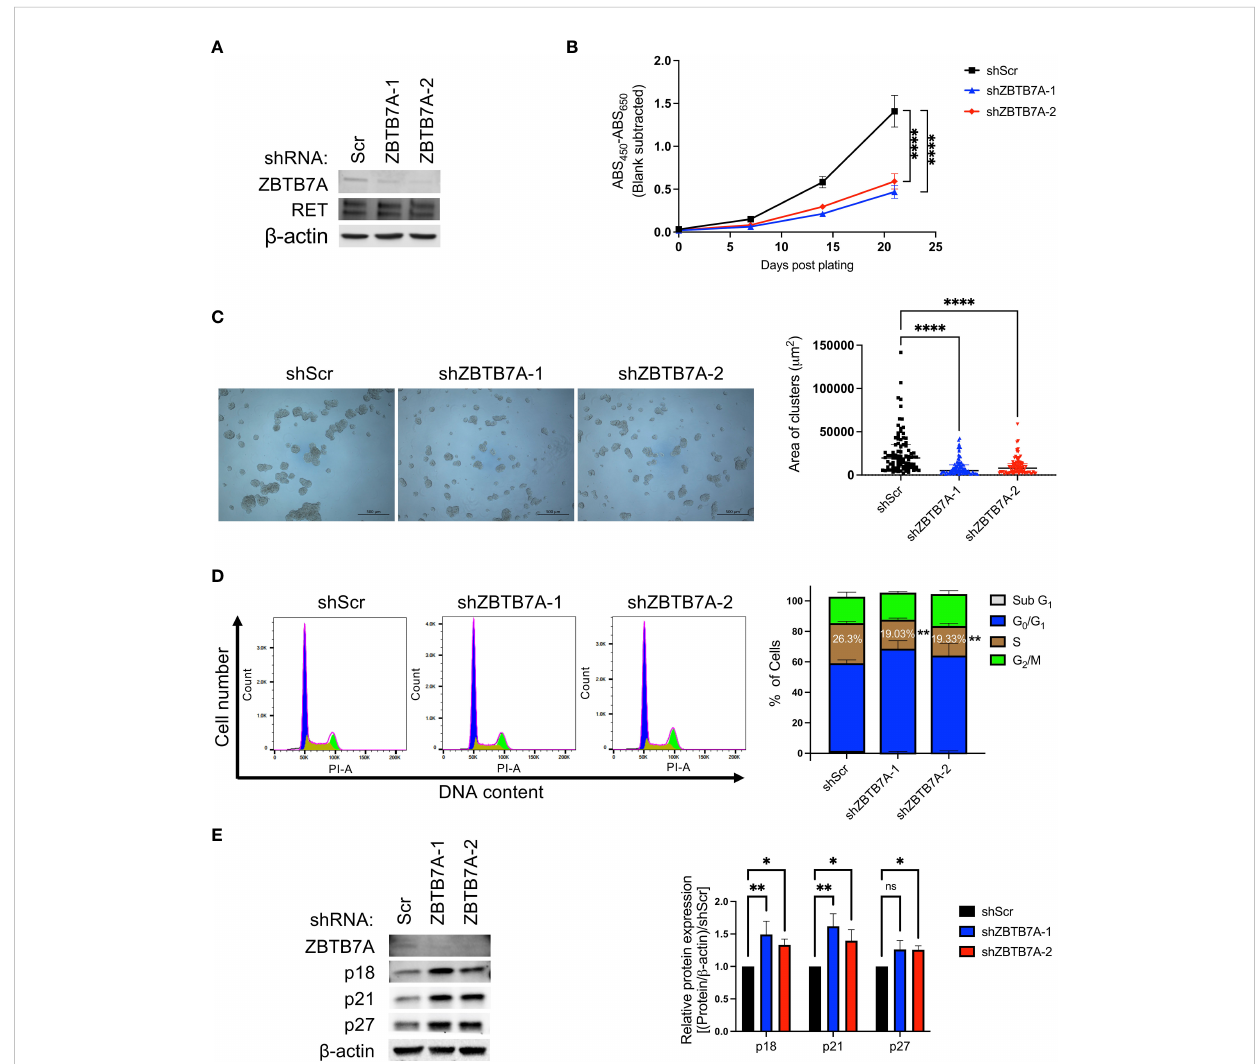
FIGURE 3 ZBTB7A knockdown reduced cell proliferation of NCI-H660 cells by blocking progression through the cell cycle. (A) ZBTB7A and RET protein expression in NCI-H660 cells stably transduced with scrambled (Scr) or two anti- ZBTB7A shRNAs. b -actin was used as a loading control. (B) Proliferation of stably transduced cells was measured every 7 days for 3 weeks via WST assay. Data are representative of three biological replicates. Error bars represent the SD of six technical replicates. Signi fi cance on Day 21 was assessed using one-way ANOVA. **** p <0.0001. (C) Representative images of each cell line in B at Day 21. Area of 90 cell clusters for each cell line (15 cell clusters/technical replicate, n = 6) were measured using Zen lite software and shown as a scatter plot with median and interquartile range. **** p <0.0001 by Kruskal-Wallis test. (D) Cell cycle analysis in NCI- H660 shScr and ZBTB7A knockdown cells using fl ow cytometry. Representative histograms showing cell cycle distribution of each cell line cultured for 48 hours after synchronization. The percentage of cell population in each cell cycle phase was calculated using FlowJo software. The stacked bars represent the mean from three biological replicates, and the error bars are SD. The statistical signi fi cance of percentage of cells in S phase was assessed against NCI-H660 shScr cells by one-way ANOVA. ** p <0.01. (E) Expression of ZBTB7A and CDK-inhibitory proteins in NCI-H660 shScr and ZBTB7A knockdown cells. Protein expression levels were quanti fi ed by densitometry using Image J software. Bars represent the mean from fi ve biological replicates, and error bars are SD. ns , non-signi fi cant, * p <0.05, and ** p <0.01 by Kruskal-Wallis